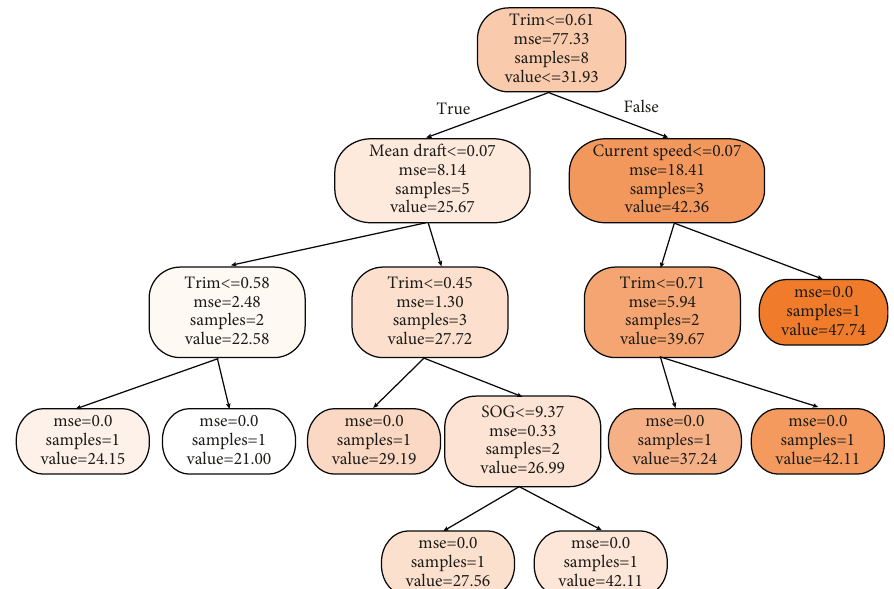
Figure 3: Visualisation of DT for predicting fuel